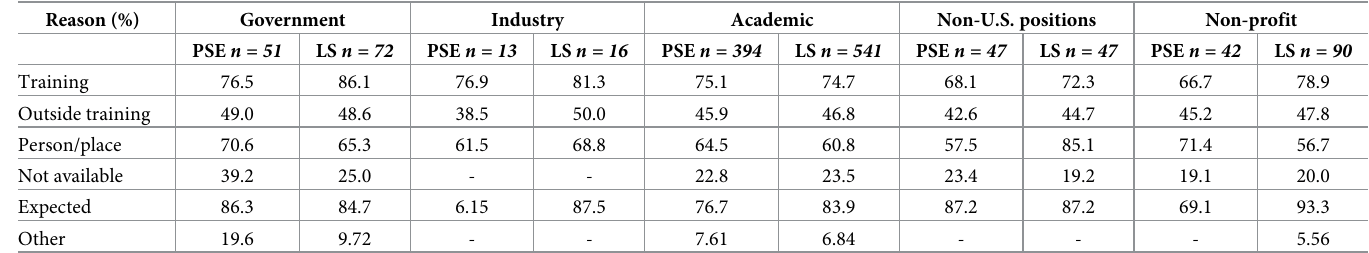
Table 6. Reasons (%) for remaining in a postdoc at Year 2 for life sciences, physical sciences and engineering. Reason (%)